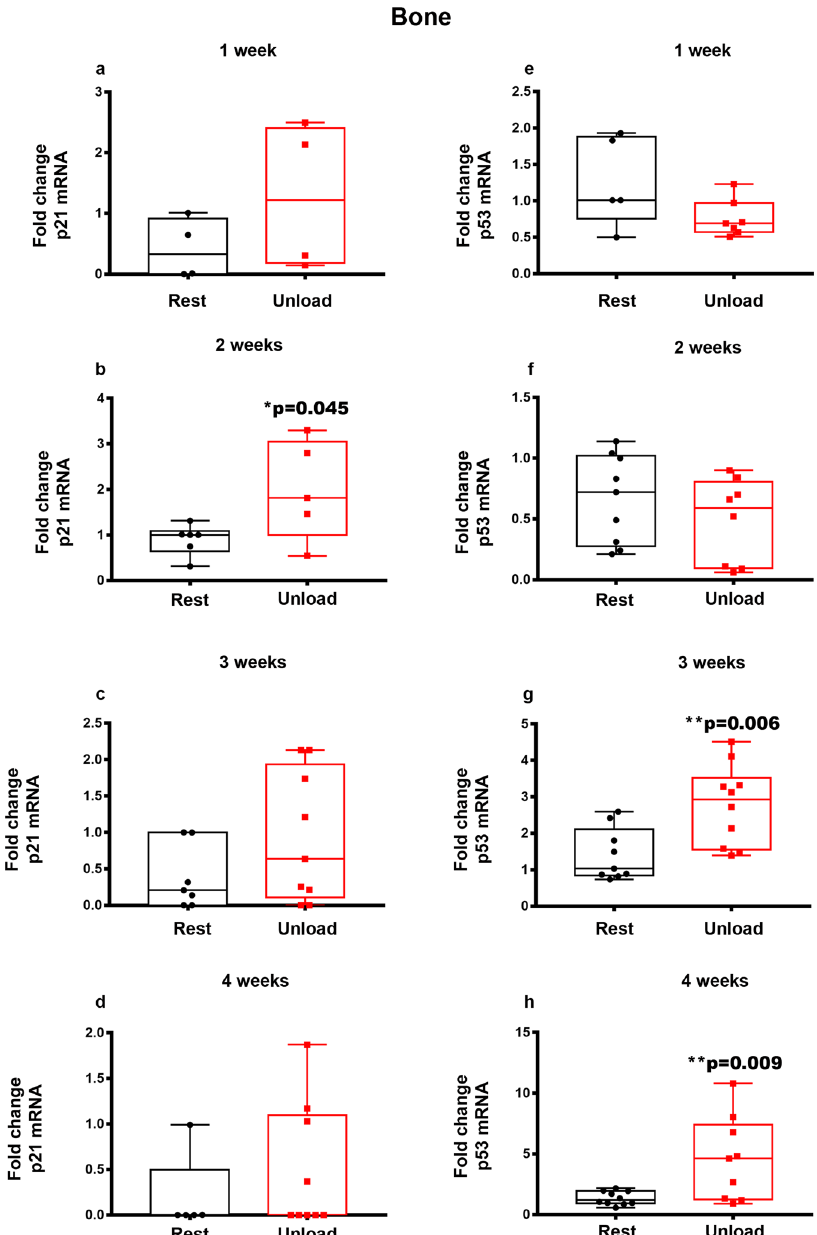
Fig. 8 p21 and p53 mRNA expression in cortical bone under unloading condition. Quantitative PCR (qPCR) showing mRNA expression levels of p21 ( a – d ) and p53 ( e – h ) in cortical bone of control mice kept in resting condition (Rest) and HU mice (Unload) at time points 1-2-3 and 4 weeks. Data showed a signi fi cant increase of p21 after 2 weeks ( b ) of suspension. In addition, we found an increase of p53 expression at 3 ( g ) and 4 ( h ) weeks of suspension. Shapiro-Wilk test and Mann-Whitney test were performed. Data are presented as box-and-whisker with median and interquartile ranges, from max to min, with all data points shown. * p < 0.05, ** p < 0.01 vs